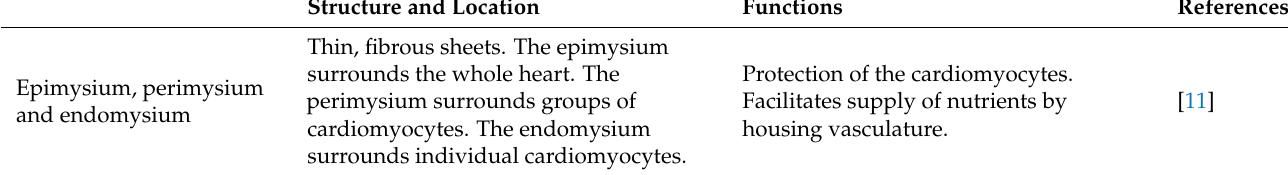
Table 1. Major structural and proteomic components of the cardiac ECM. Structure and Location